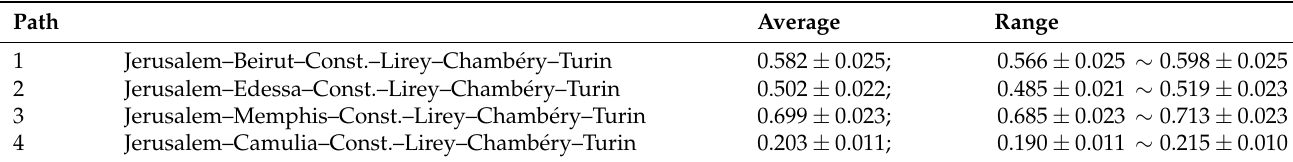
Table 3. Predicted average, minimum, and maximum CB nor in the alleged paths of the Shroud in the year 2021, with their average standard deviations due to constants’ uncertainties (see Figure 1).